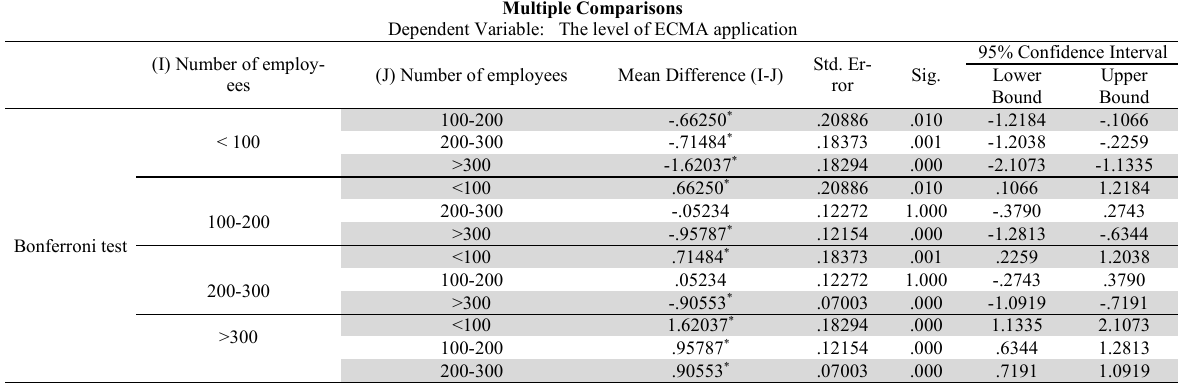
Verifying difference between the level of ECMA application and number of employees Multiple Comparisons Dependent Variable: The level of ECMA application